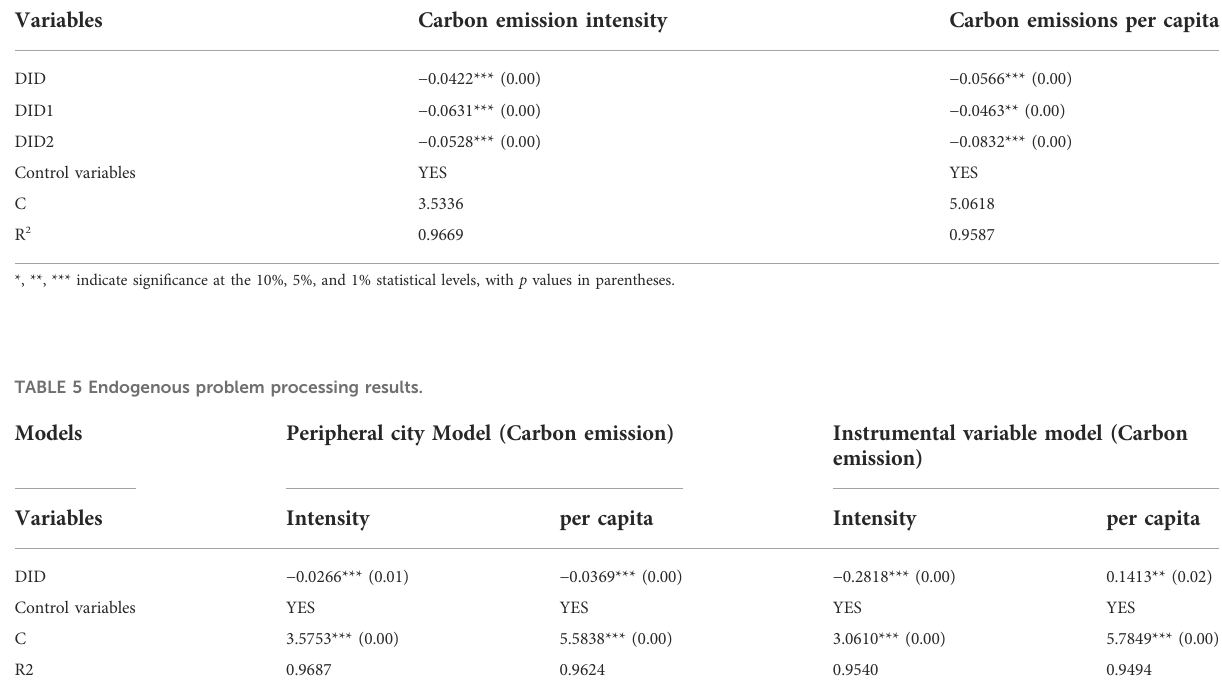
TABLE 4 Regression results excluding other pilot policies.